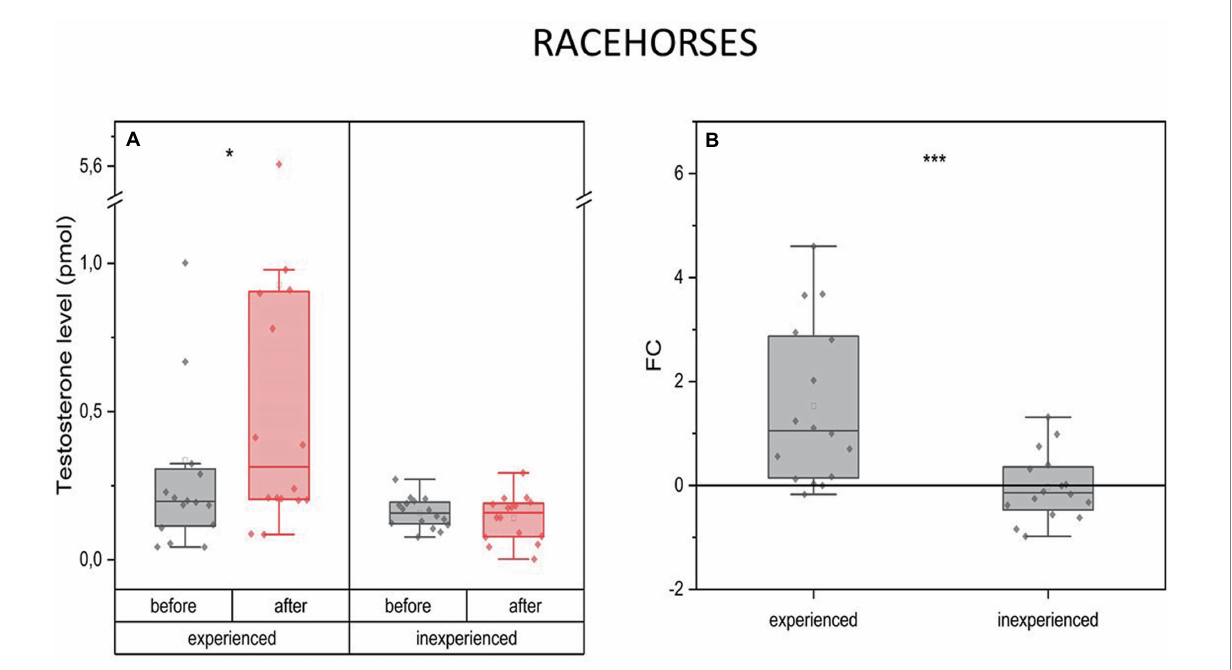
FIGURE 1 Changes in testosterone plasma level upon training in experienced ( n = 16) and inexperienced ( n = 16) racehorses. Box plots (IQR, mean and median; whisker range within 1,5IQR) expressed as differences in molar plasma concentration (A) and fold change (FC) (B) . Statistically significant differences are indicated by asterisks at p < 0.05 (*), p < 0.01 (**), and p < 0.001 (***).